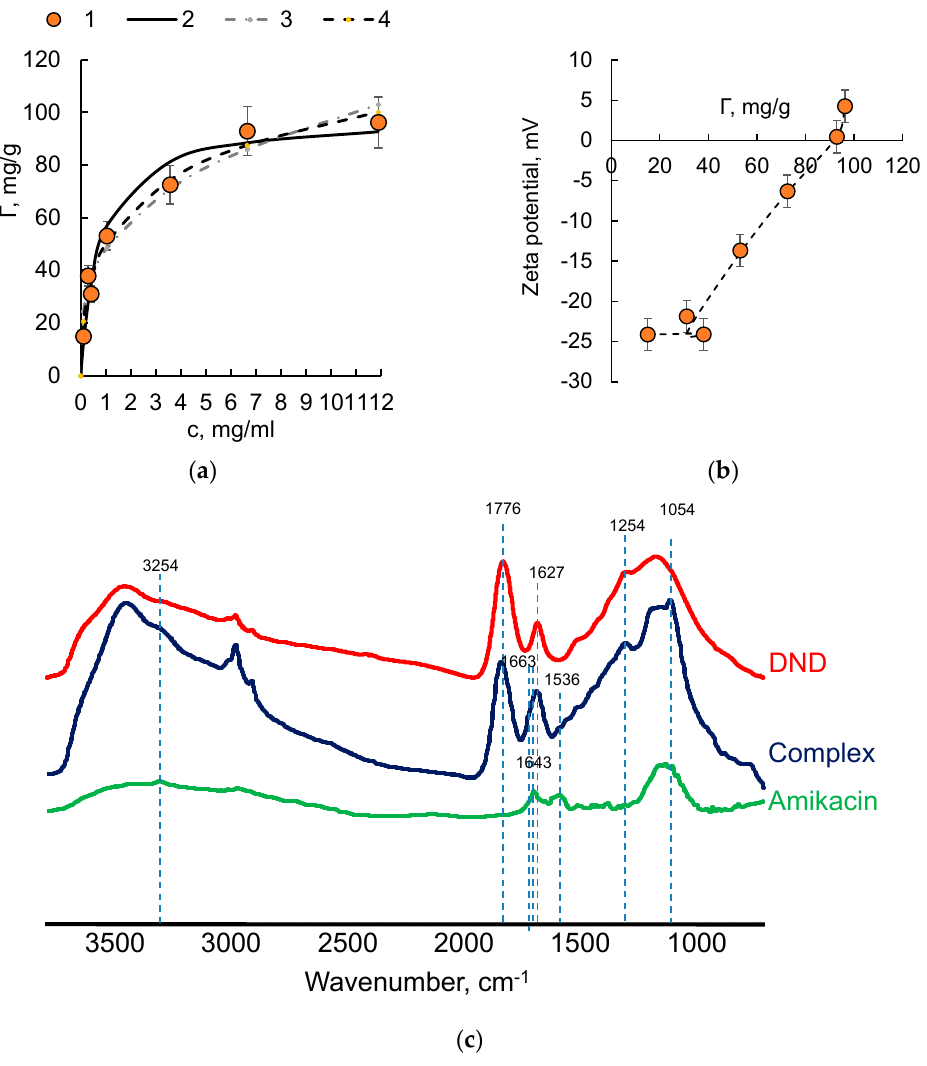
Figure 4. Characteristics of DND–amikacin complex. ( a ) The dependence of amikacin surface concentration on its equilibrium concentration in the aqueous phase. (1) Experimental data, (2) fitting with Langmuir equation, (3) fitting with Freundlich equation, (4) fitting with Dubinin–Radushkevich equation. ( b ) The dependence of zeta potential of DND–amikacin species in the aqueous suspension on amikacin surface concentration. ( c ) FTIR spectra of DND, DND–amikacin complex and amikacin.